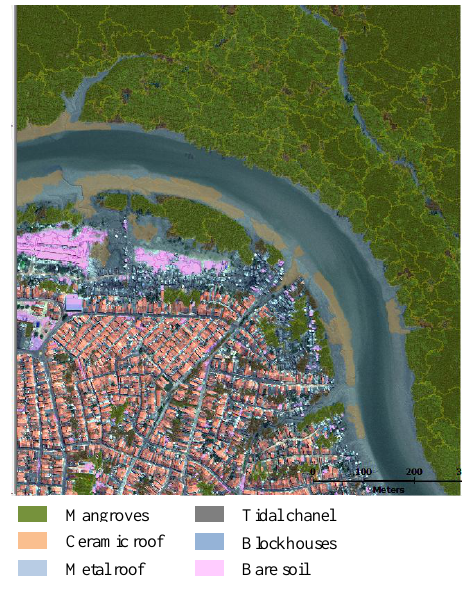
Figure 8: Land Cover